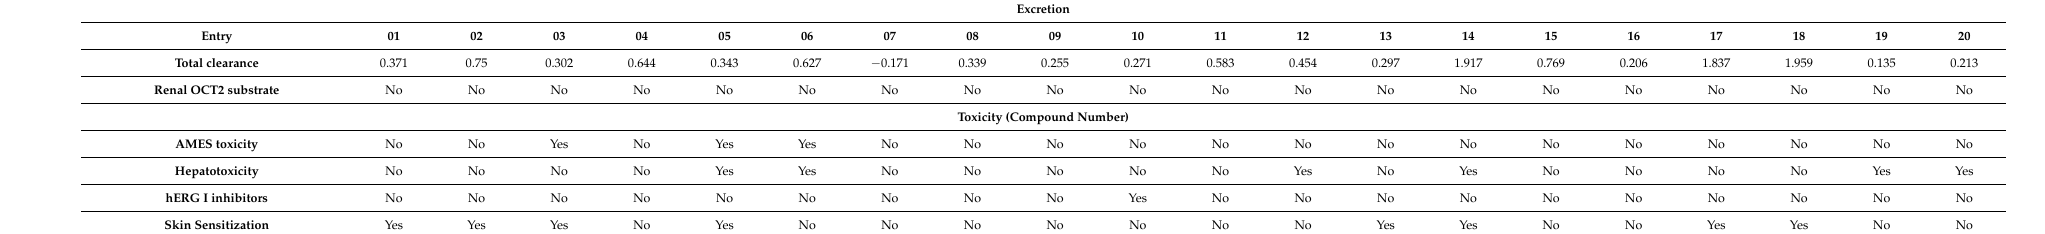
Absorption, distribution, metabolism, excretion and toxicity (ADMET) properties of the identified phytochemical compounds of E. sativa : (21) glucoraphanin; (22) (S)-2-(Hydroxymethyl)glutarate; (23) 2-Deoxy-scyllo-inosose; (24) artomunoxanthentrione epoxide; (25) fraxidin; (26) N